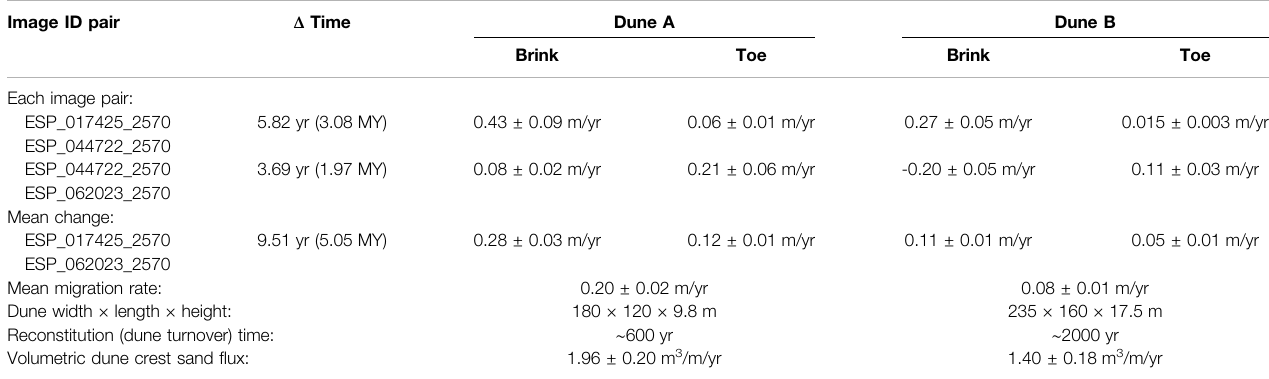
TABLE 2 | Dune migration rates. Image ID